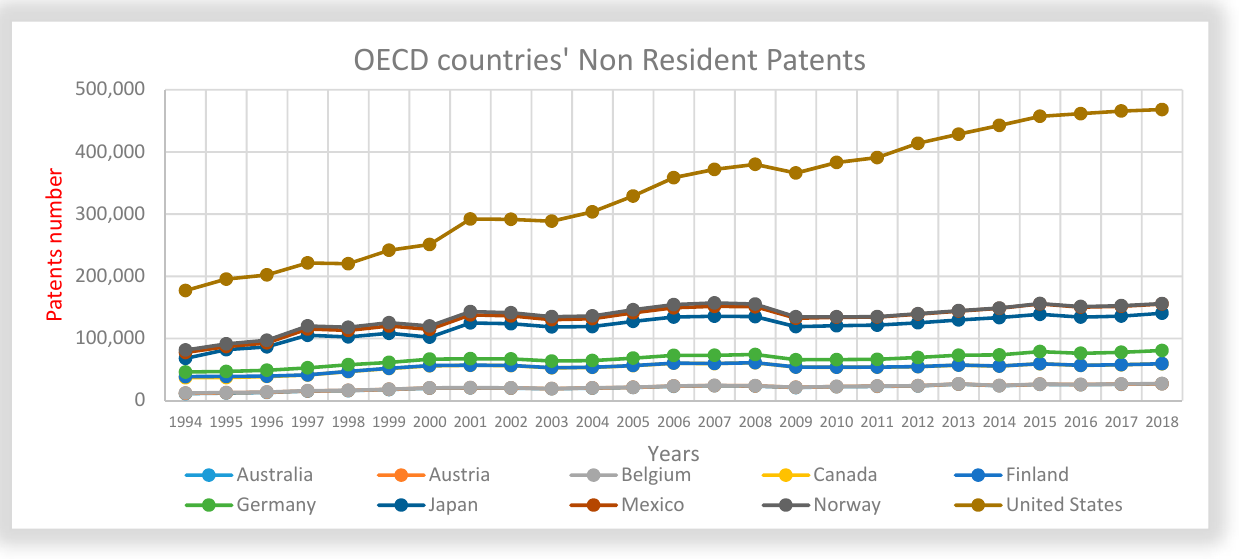
Figure A4. Ten OECD countries’ non-resident patents (number).